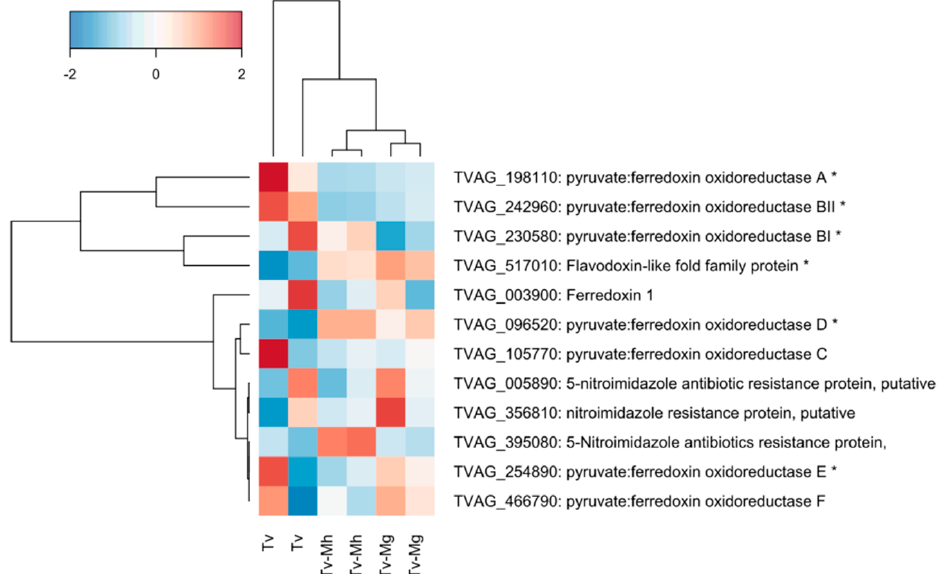
Figure 3. The differential expression of selected T. vaginalis genes related to metronidazole resistance alone and in association with M. hominis or with Ca. M. girerdii. Expression units are z-scaled trimmed mean of M-values (TMM). * Indicates genes with a statistically significant difference of expression between Mycoplasma- free T. vaginalis iSS62-Mh − Mg − (Tv) and T. vaginalis associated with M. hominis iSS62-Mh + Mg − (Tv-Mh).